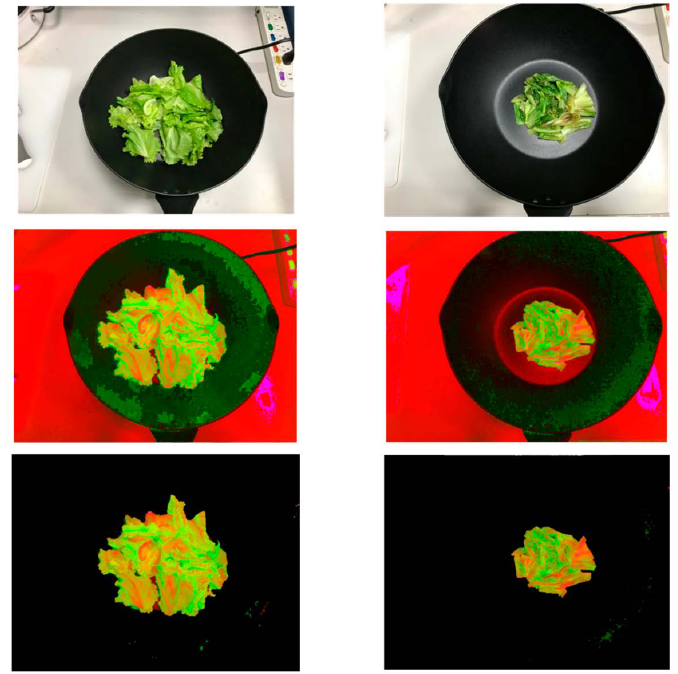
Figure 7. The cooking of the Lettuce. Upper: Lettuce original image, Middle: HSV false color operation image, Bottom: target extraction. Left: Beginning. Right: Finish.